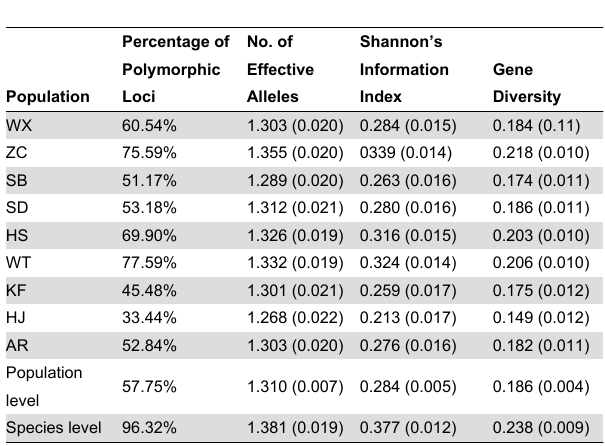
Table 3. Analysis of the genetic variation of P. eryngii var. tuoliensis